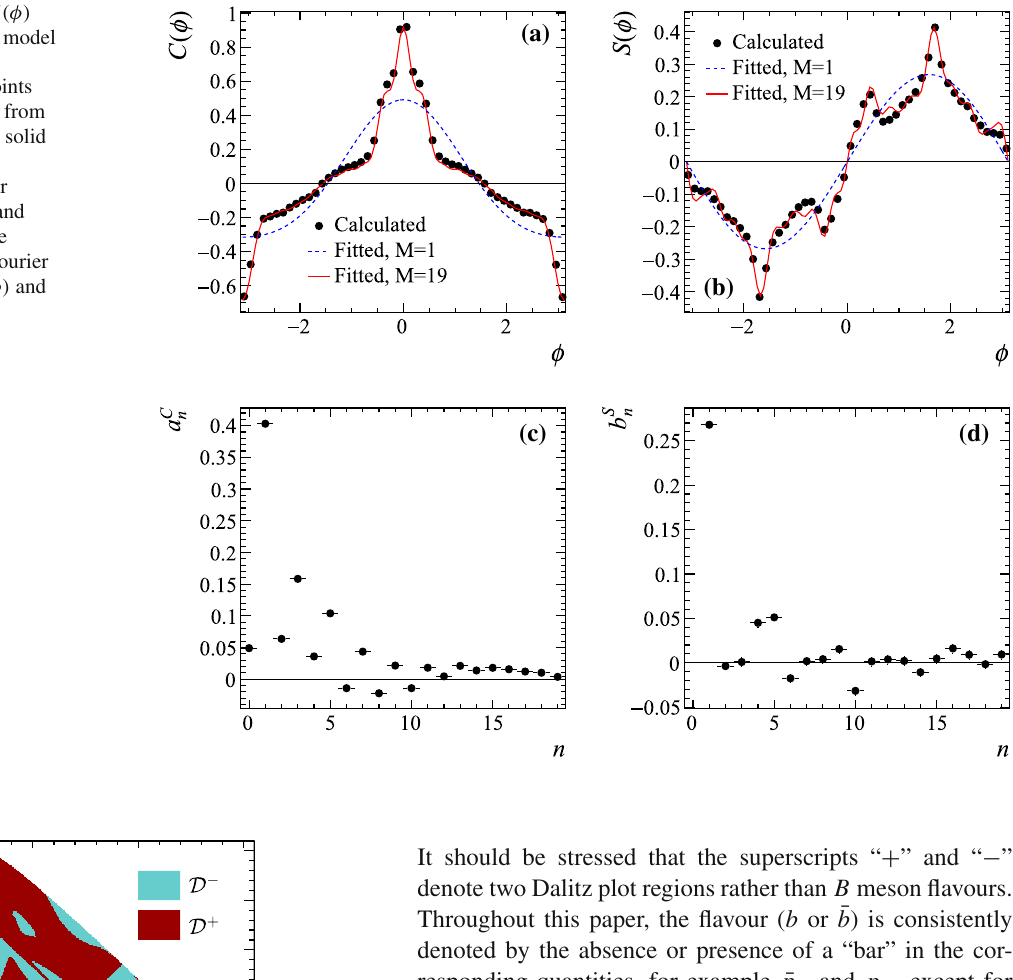
Fig. 3 a The functions C (φ)